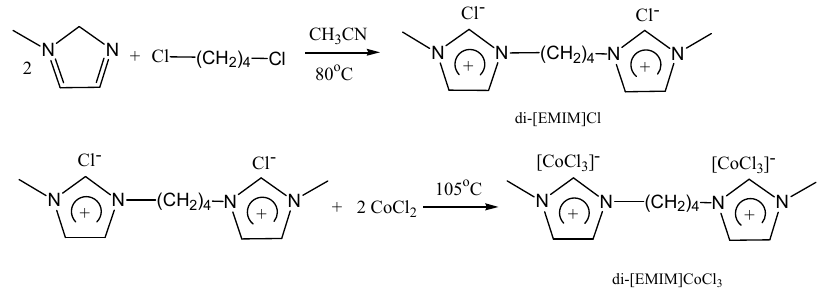
Figure 1. Synthesis process of di-[EMIM]CoCl 3.